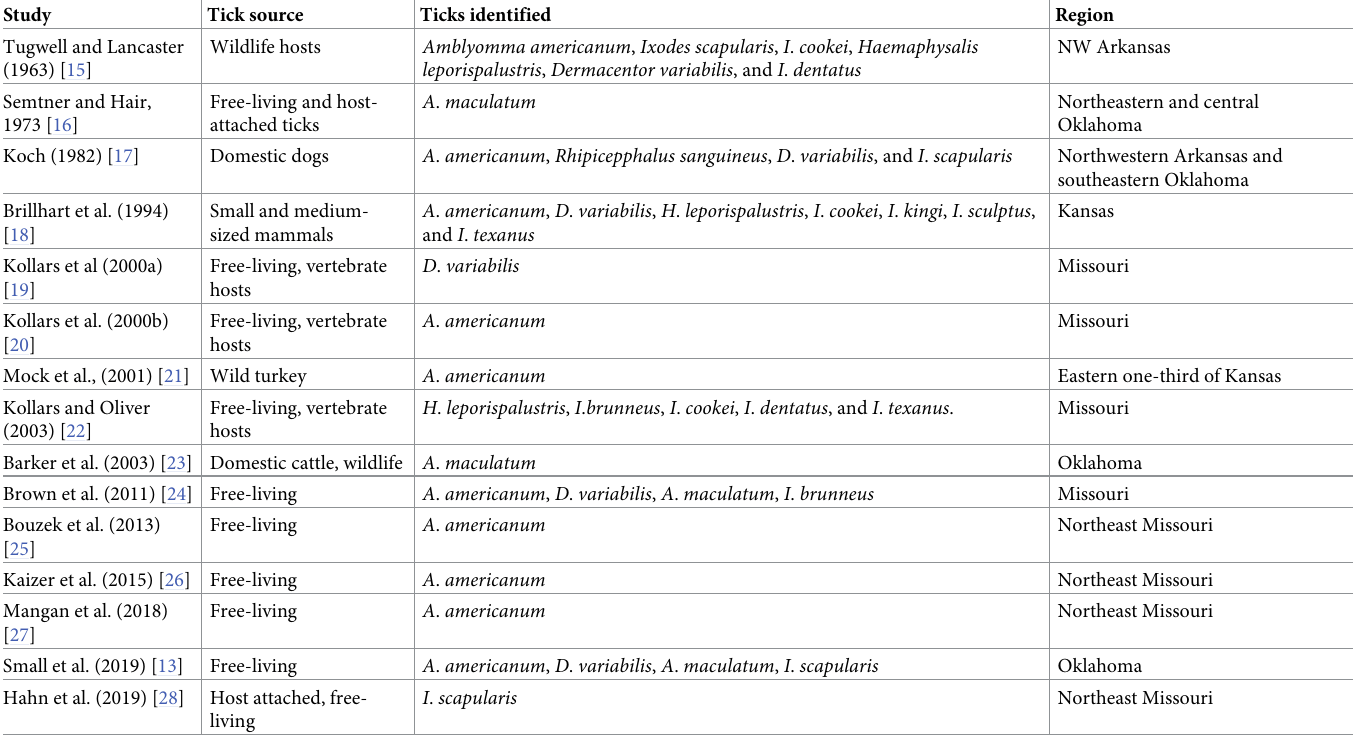
Table 1. Previous tick phenological studies in the